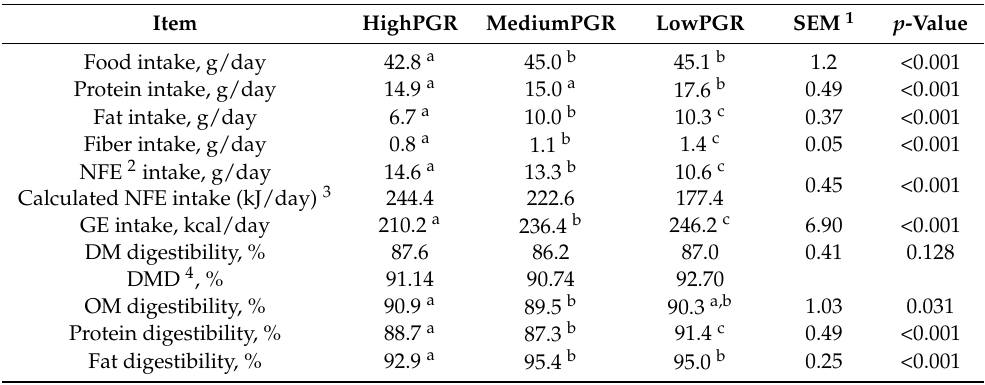
Table 3. Intake and total tract digestibility of nutrients in cats of three experimental diets differing in perceived glycemic response (PGR).